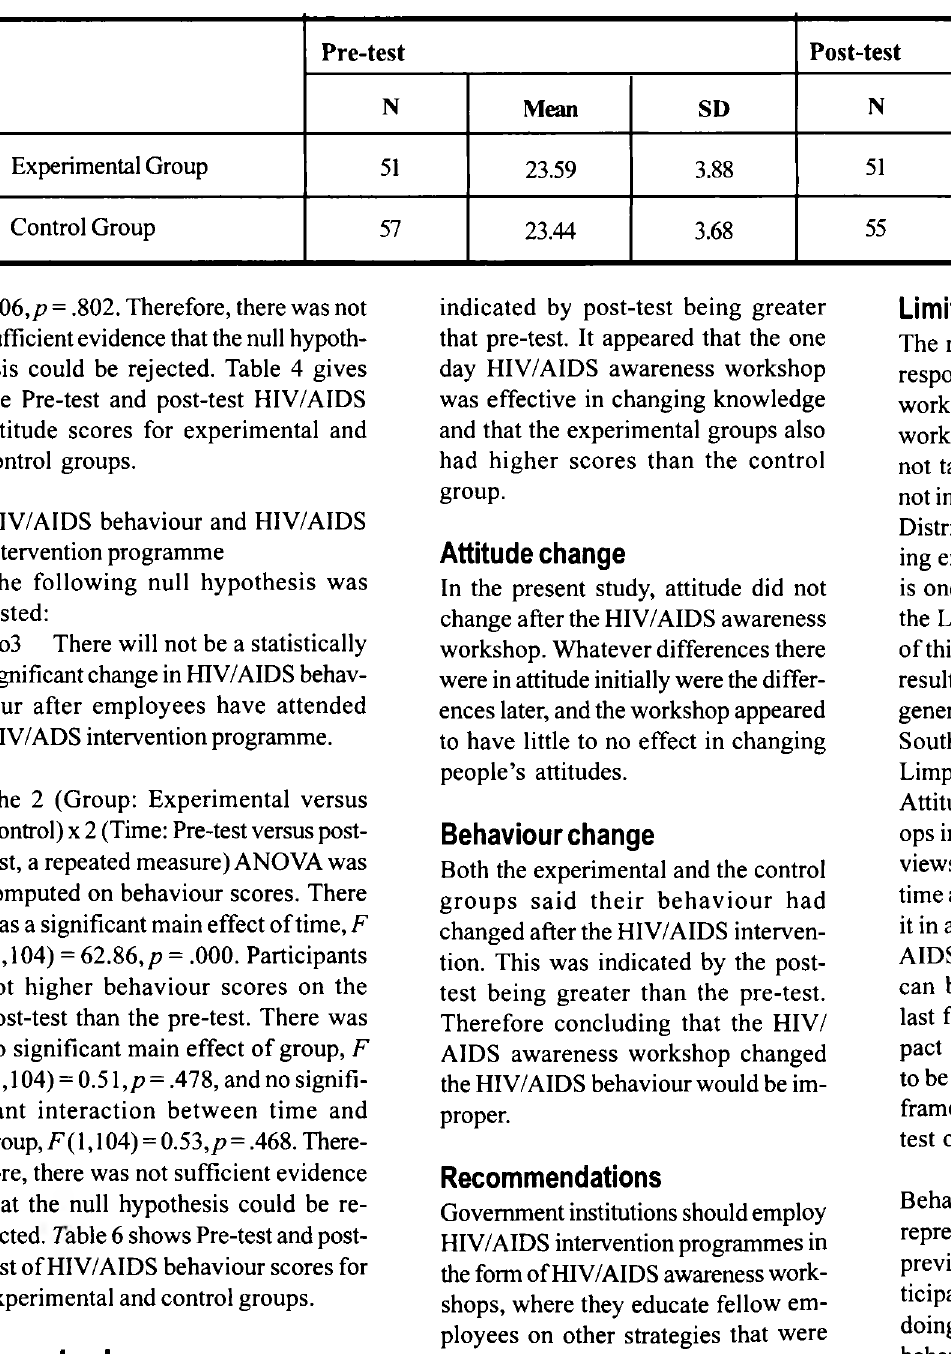
Table 6: Pre-test and post-test of HIV/AIDS behaviour scores for experimental and control